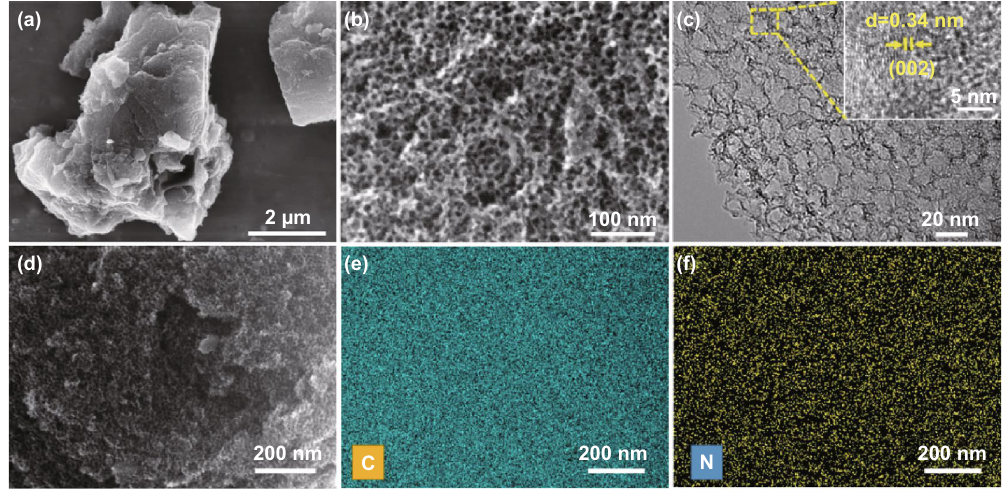
Fig. 2 a , b SEM, and c TEM images of NPC-1000, d – f SEM image of NPC-1000 and corresponding elemental mapping images of C and